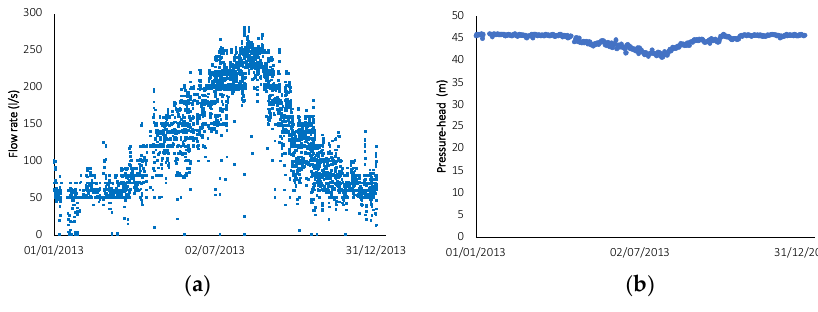
Figure 2. Historical data of ( a ) flow rate and ( b ) pressure-head over one year at the identified location for energy recovery (PA).